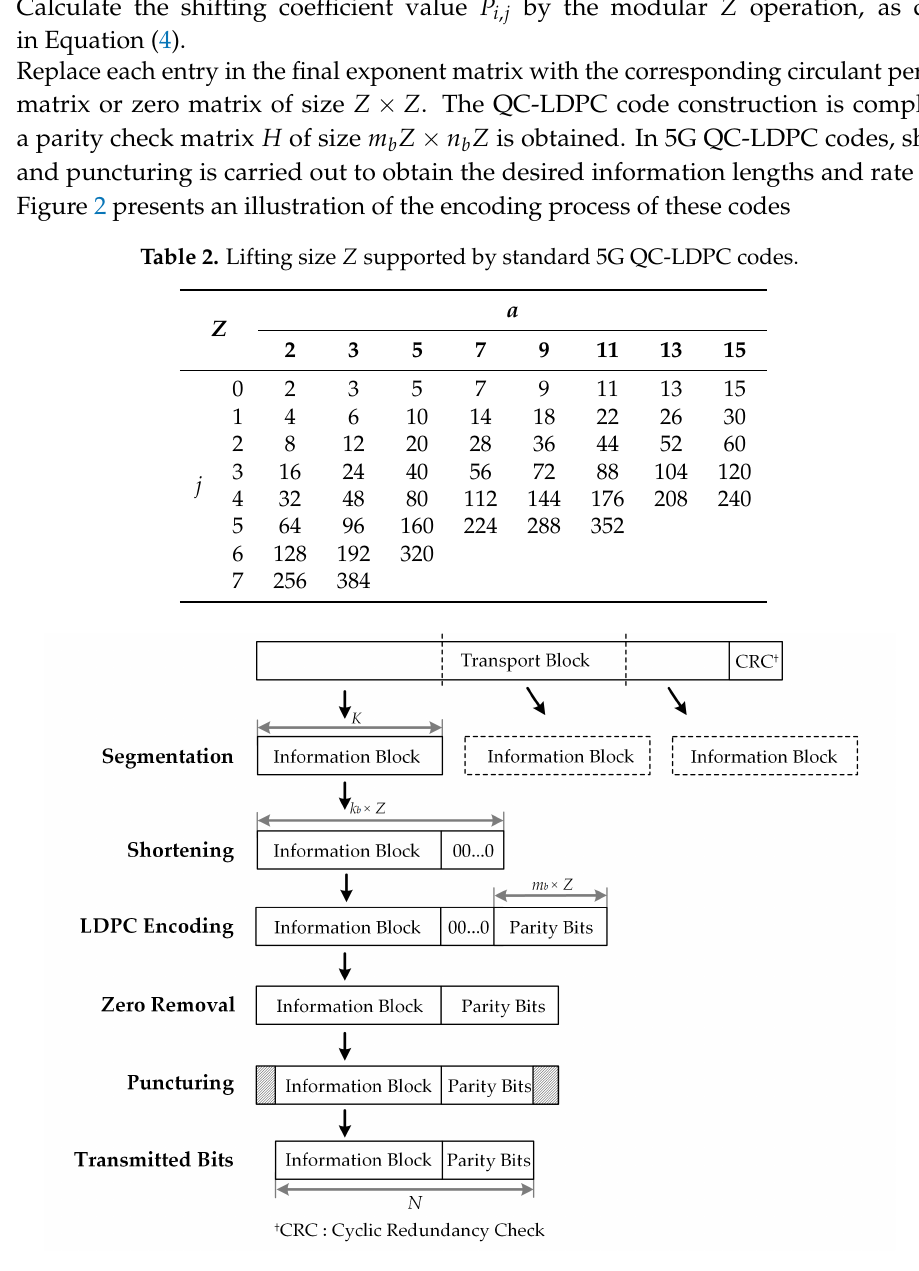
Figure 2. Shortening by zero padding and puncturing of standard 5G QC-LDPC